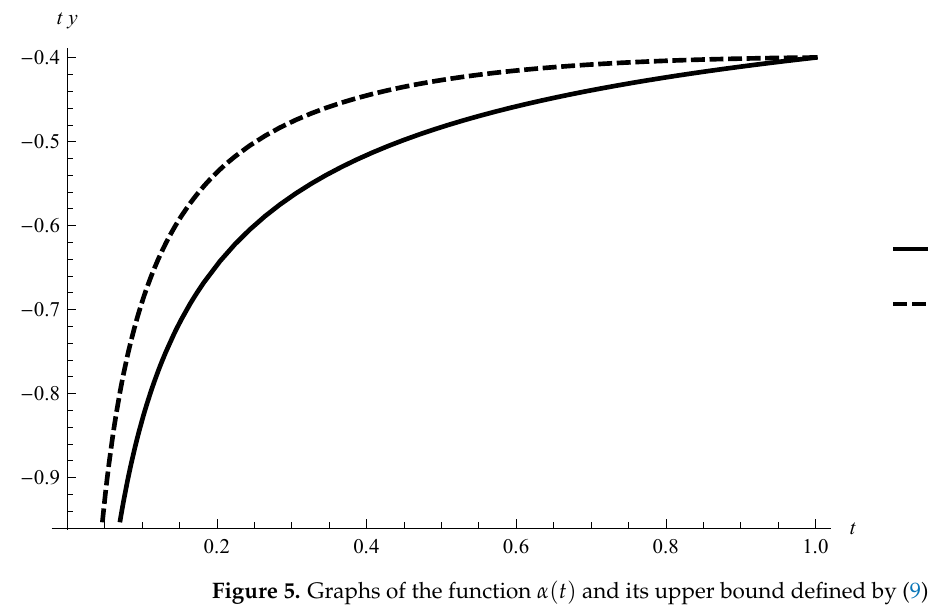
Figure 5. Graphs of the function α ( t ) and its upper bound defined by (9).